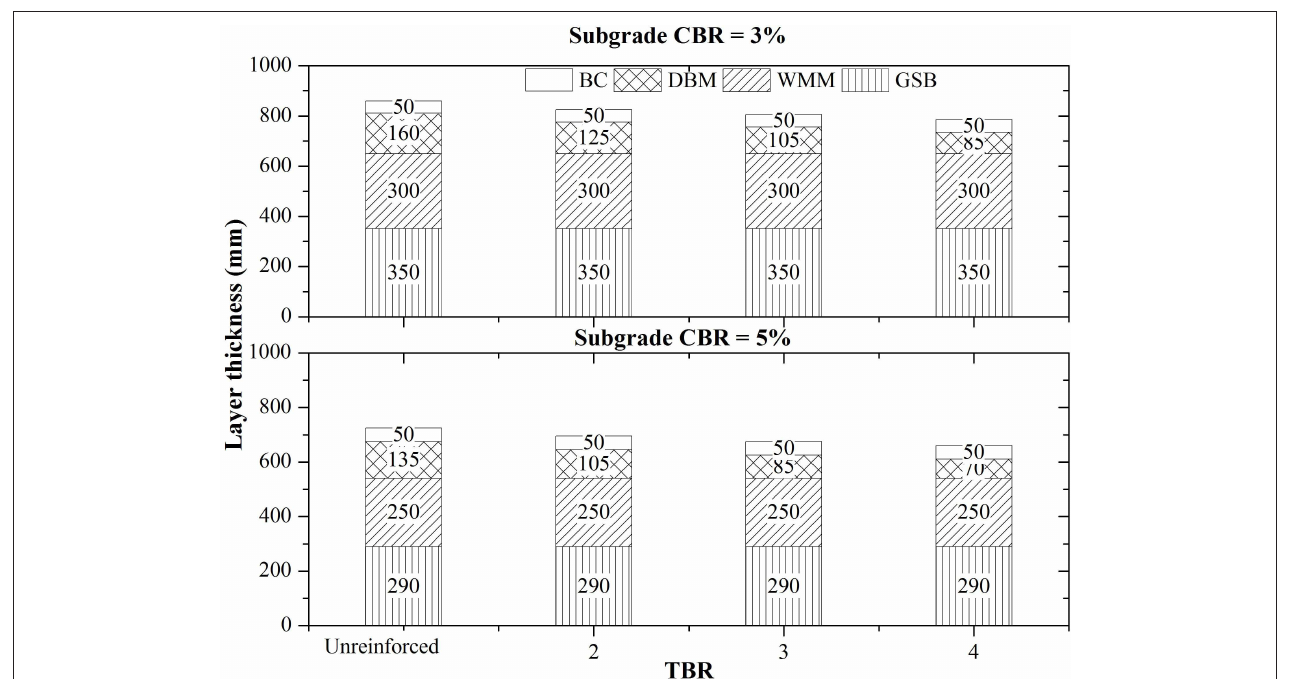
FIGURE 5 | Design charts showing thicknesses of unreinforced and geogrid-reinforced flexible pavements using TBR approach based on Objective-2 for the traffic of 100 MSA with subgrade CBRs equal to 3 and 5%.